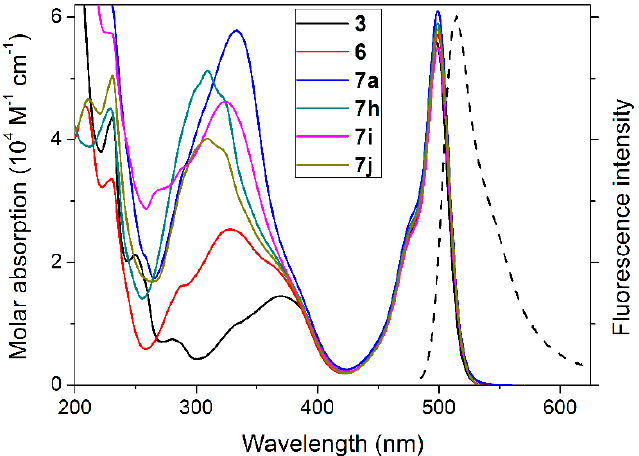
Figure 2. UV-Vis absorption and fluorescence (dashed line) of representative BODIPY-coumarin hybrids in diluted solution of cyclohexane. The reference BODIPY not bearing 8-coumarin 3 is also included for comparison. Note that the shape and position of the fluorescence spectra does not change nor with the kind of tethered coumarin neither the excitation wavelength (UV or Vis) owing to the ongoing intra-EET. The absorption spectra of the rest of the dyads are collected in Figure S1 in Supplementary Material.